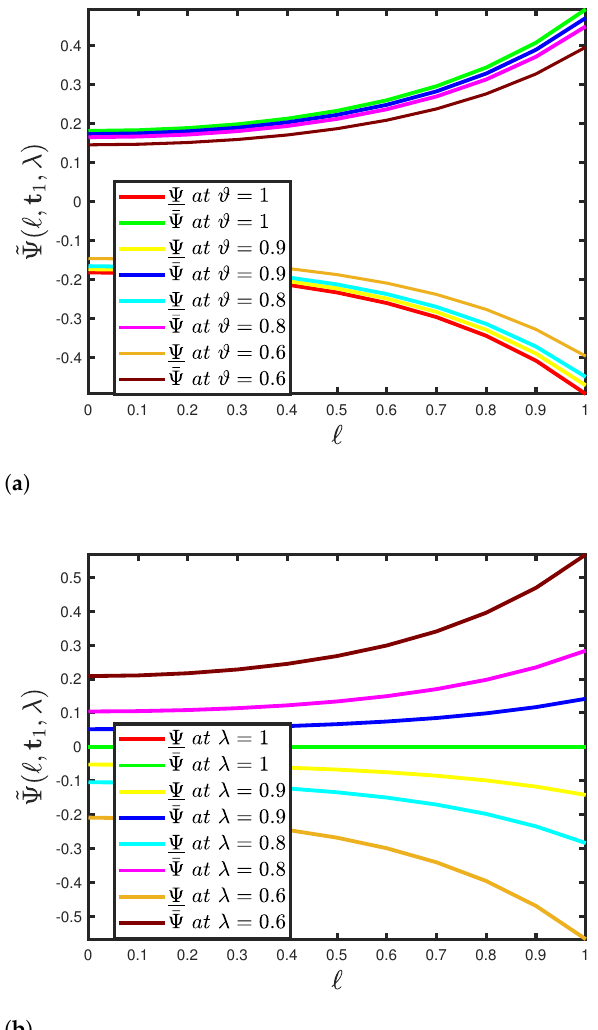
Figure 6. Two-dimensional simulation of ˜ Ψ ( (cid:96) , t 1 ; λ ) of Problem (2): ( a ) Ψ ( (cid:96) , t 1 ; λ ) and ¯ Ψ ( (cid:96) , t 1 ; λ ) when fuzzy CFD is considered to have an uncertainty parameter λ ∈ [ 0,1 ] and t 1 = 0.7; and ( b ) Ψ ( (cid:96) , t ) and ¯ Ψ ( (cid:96) , t ) when fuzzy CFD is considered to have a fractional order ϑ = 0.7 and 1 ; λ 1 ; λ t 1 =